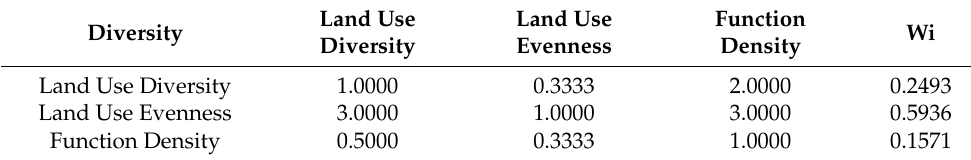
Table A10. Diversity Consistency ratio: 0.0516; Weight of “5D”: 0.2270; λ max: 3.0536.